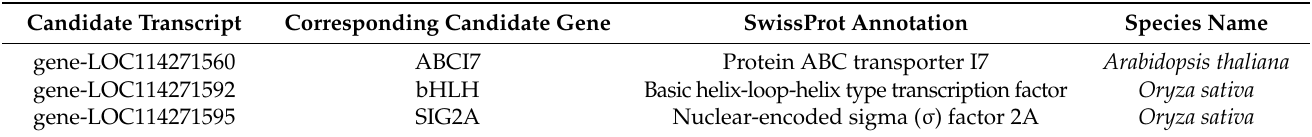
Table 7. Candidate genes related to the development of leaf